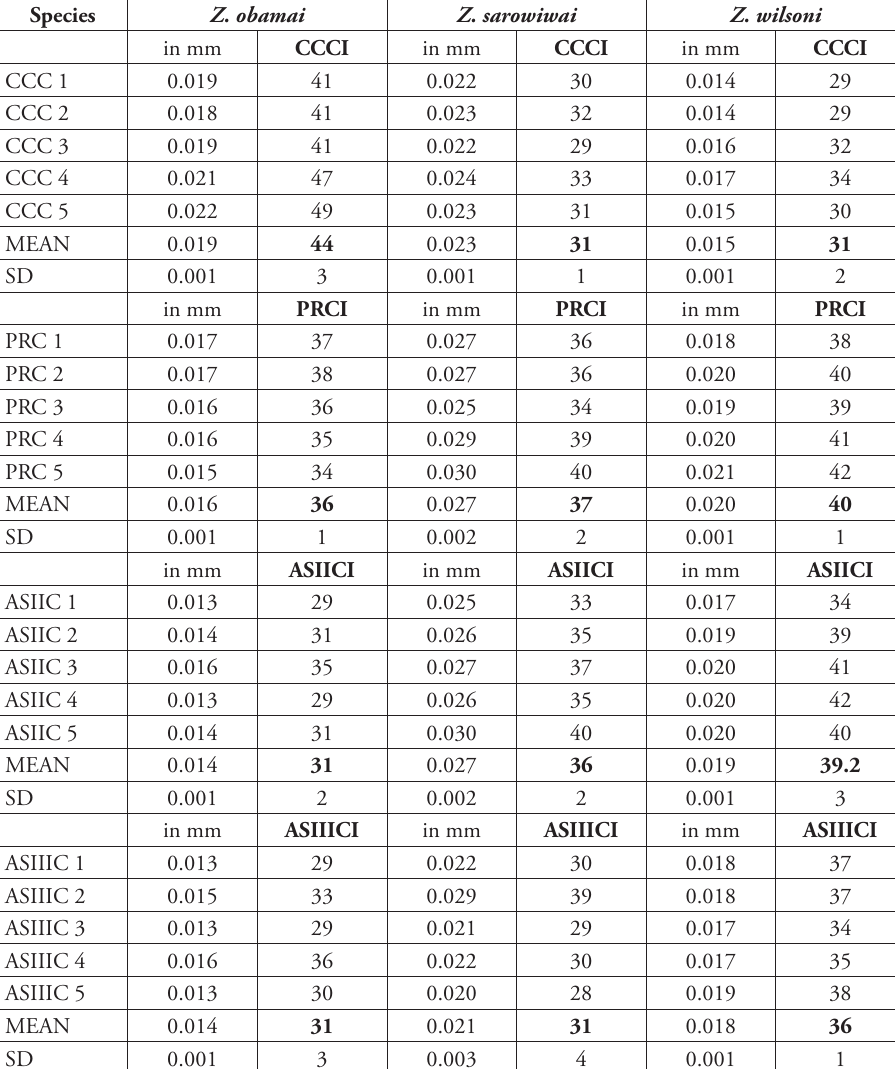
Table 5. Morphometric data generated from 3D measuring cuticle thickness. For each species the five raw measurements with corresponding calculations into indices are given, as well as mean values and standard deviations